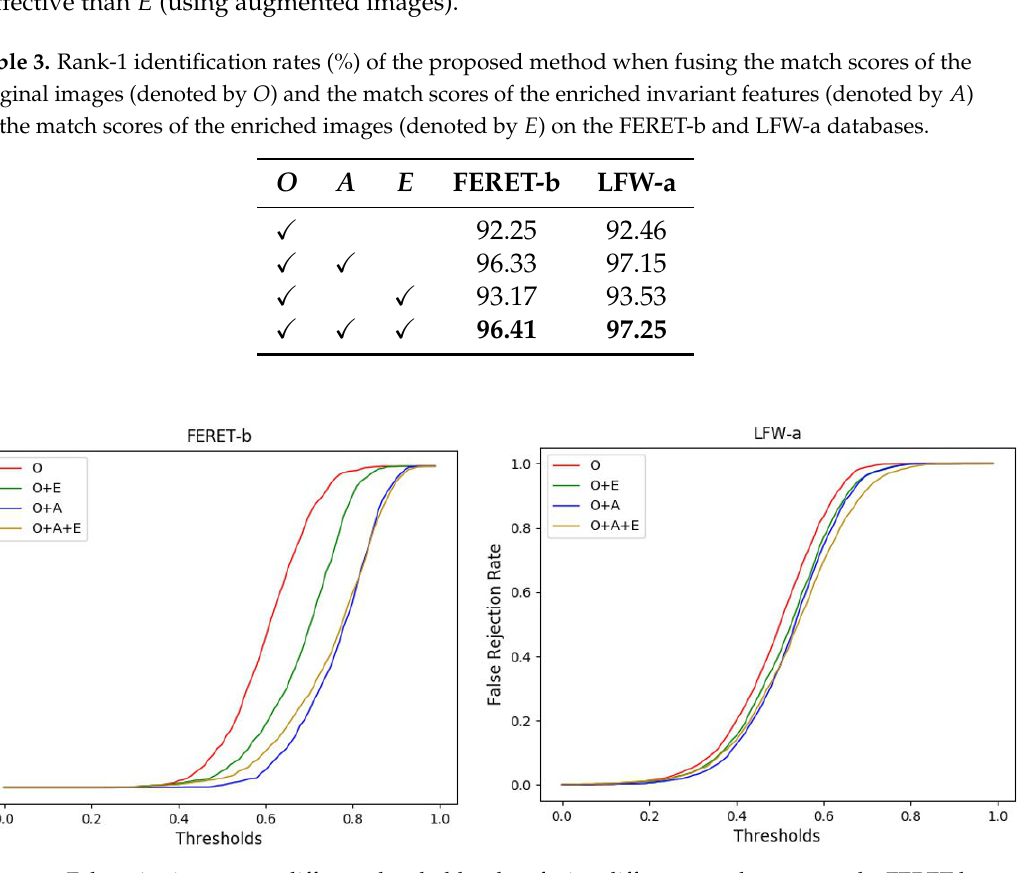
Figure 6. False rejection rates at different thresholds when fusing different match scores on the FERET-b and LFW-a